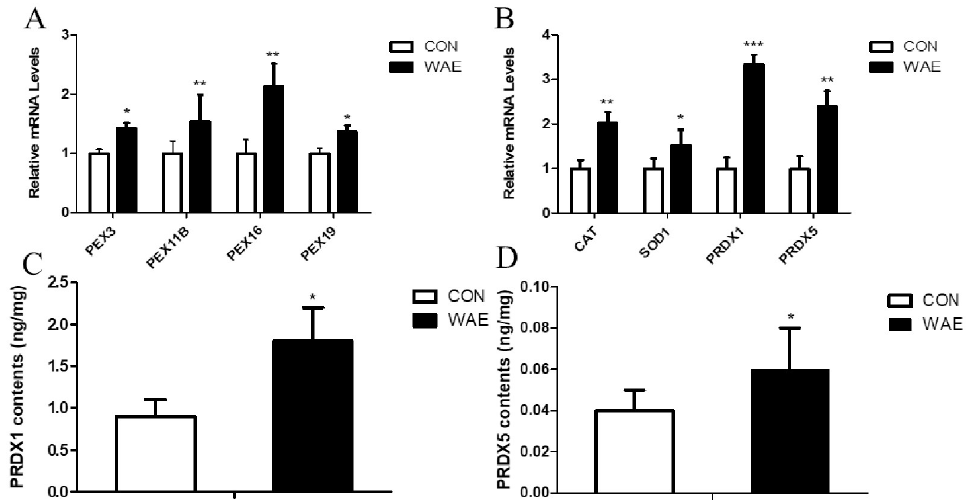
Fig 6. qPCR and ELISA were used to detect liver tissues PEX3, PEX11B, PEX16, PEX19, CAT, SOD1 and other key genes and PRDX1, PRDX5 protein content. (A) mRNA expression levels of key genes in peroxisome biosynthesis in the liver; (B) mRNA expression levels of key peroxisome antioxidant genes in the liver; (C) Peroxiredoxin 1 (PRDX1) content in the liver; (D) Peroxiredoxin 5 (PRDX5) content in the liver; � : (P < 0.05) �� : (P < 0.01) ��� : (P <